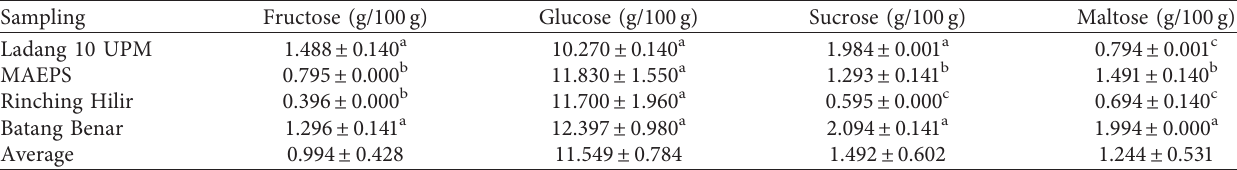
Table 3: Sugar content (fructose, glucose, sucrose, and maltose) in bee bread samples.